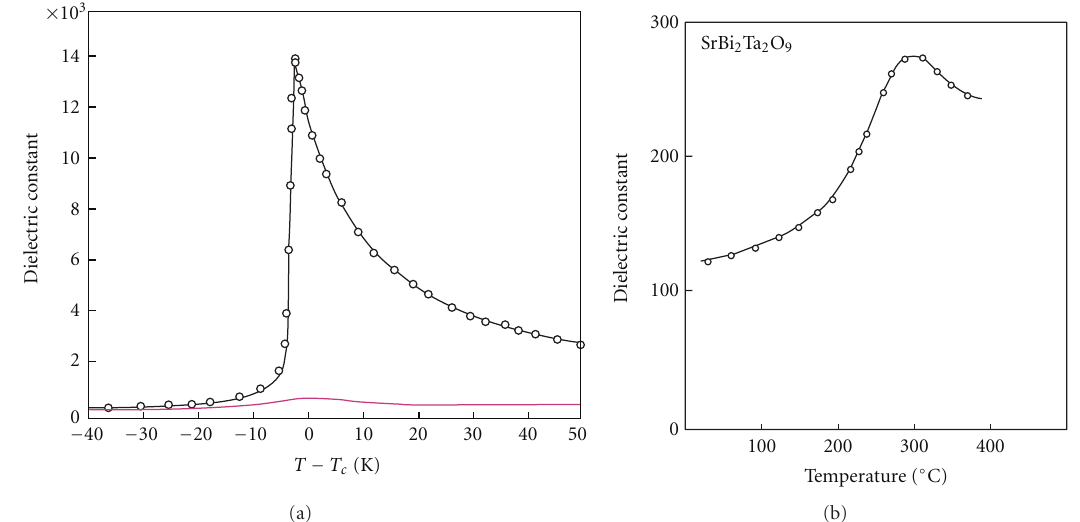
Figure 1: Temperature dependence of dielectric constant of (a) BaTiO 3 (black line) and SrBi 2 Ta 2 O 9 (red line) and (b) that of an expanded figure in SrBi 2 Ta 2 O 9 [6].